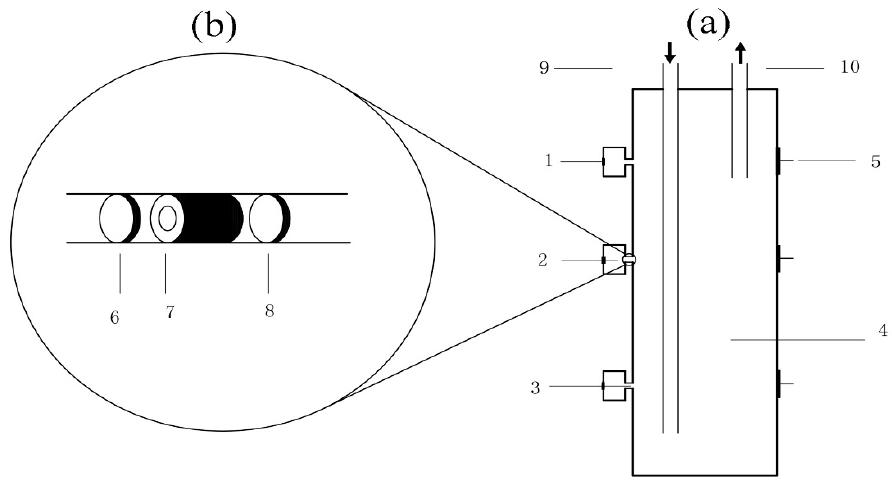
Figure 2. A schematic diagram of the occluded corrosion cavity simulation cell ( a ) and the enlarged schematic diagram of the di ff usion channel in the occluded corrosion cavity simulation cell ( b ). (1) anode, (2) occluded area, (3) di ff usion channel, (4) flowing area, (5) cathode, (6) filter paper, (7) simulation corrosion scales, (8) filter paper, (9) flowing water inlet, (10) flowing water outlet. Table 1. Elemental composition of ductile iron by energy dispersive X-ray spectroscopy.